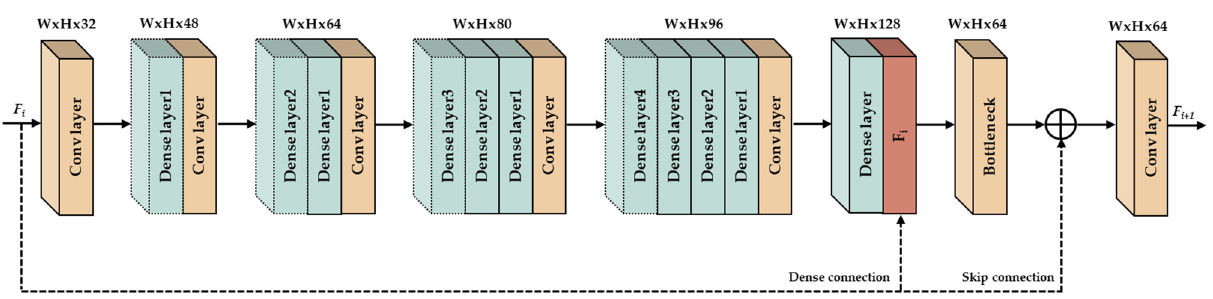
Figure 2. The architecture of a DC block.